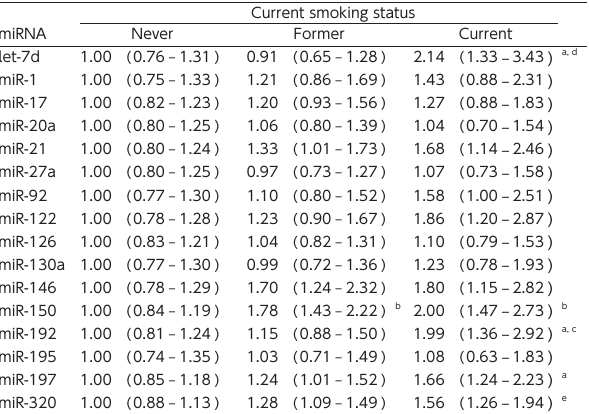
Table 2. Adjusted relative serum miRNA levels by smoking status